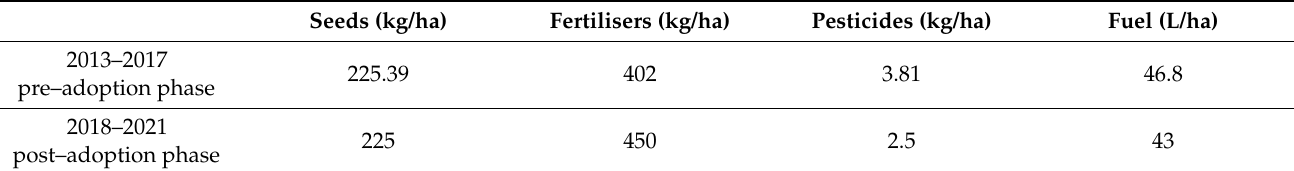
Table 2. Variation in the volume of